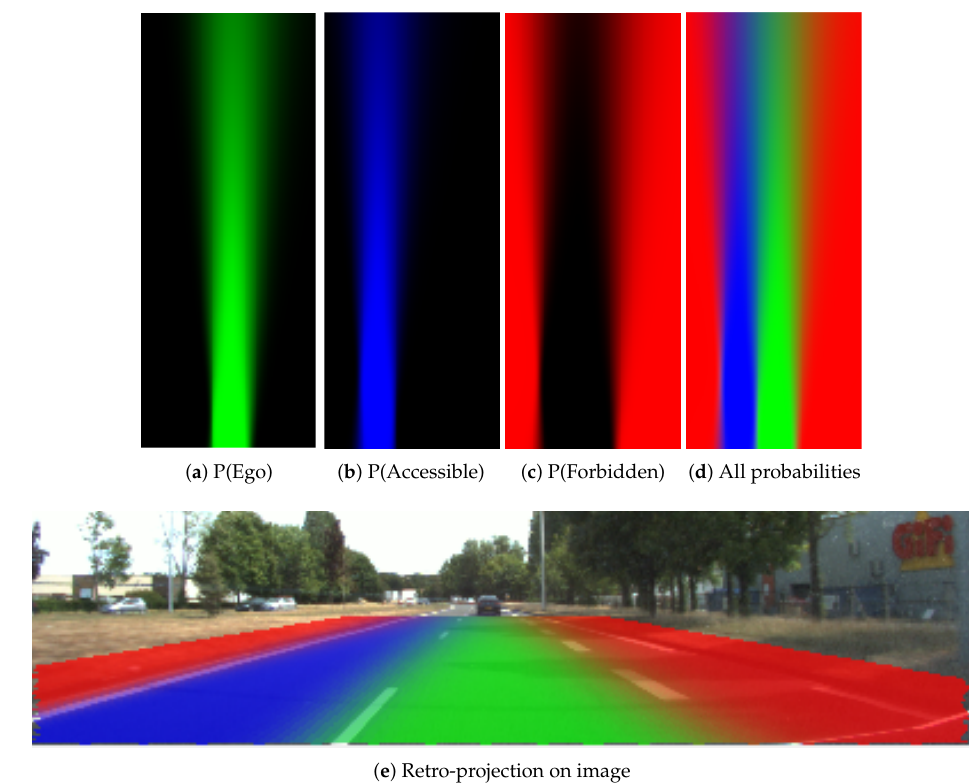
Figure 12. Probabilistic grids with small uncertainty ( σ x = 0.2 m, σ y = 0.3 m, σ θ = 0.1 radians ) .